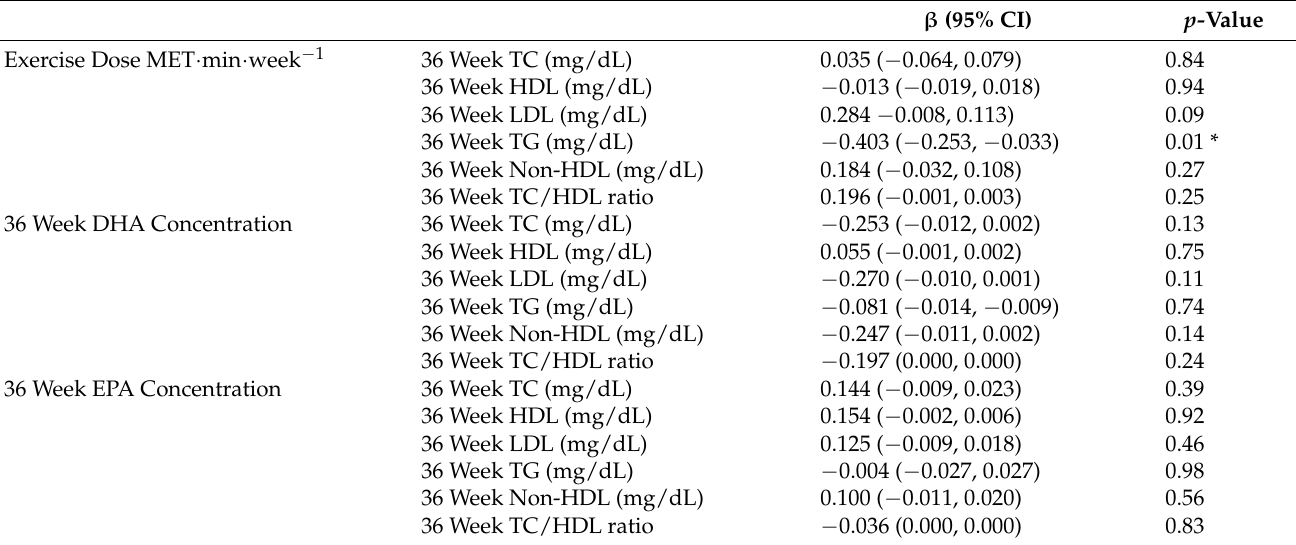
Table 4. Multiple linear regression models of maternal exercise dose, DHA concentration, and EPA concentration influence on maternal lipid profiles at 36 weeks of gestation. β (95% CI) p-